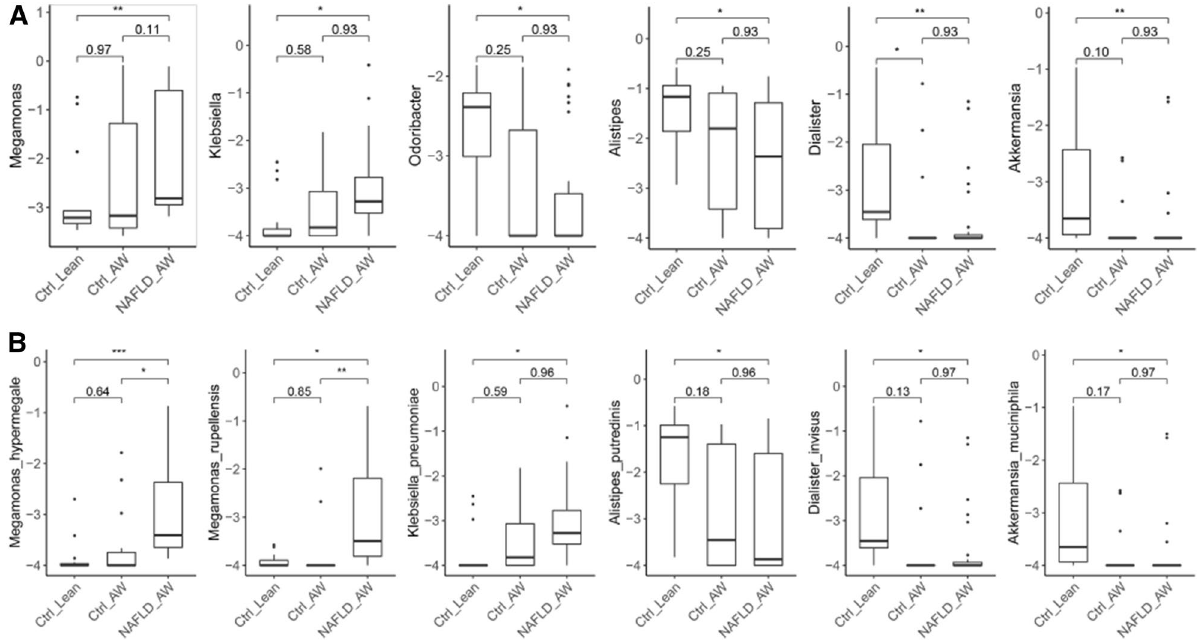
Figure 5. Comparison of gut microbial compositional features at the genus and species levels between the BMI- MRS 3 groups using the Wilcoxon rank-sum test. ( A ) The genus Megamonas is enriched in the NAFLD_AW group, while Odoribacter , Alistipes , Dialister , and Akkermansia are depleted compared with the Ctrl_Lean or Ctrl_AW group at the genus level. ( B ) Megamonas hypermegale and Megamonas rupellensis exhibit a significant increase in NAFLD_AW children when compared with the Ctrl_Lean or Ctrl_AW group at the species level. Note: *, BH-adjusted P < 0.05; **, BH-adjusted P < 0.01; ***, BH-adjusted P <